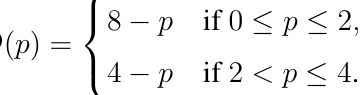
Figure 3. Example 4: Operating profit as a function of price.